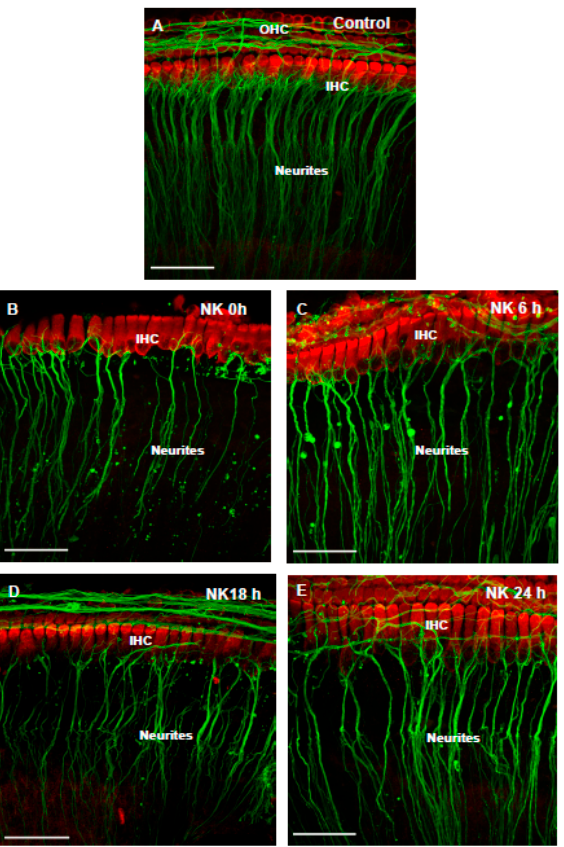
Figure 2. The effect of excitoxic injury in the neonatal rat cochlea induced by co-administration of N-methyl-D-aspartate ( NMDA) and kainic acid (NK treatment). Images B–E show the NK effect in the function of time in order to find the best post-NK time point for further experiments in the study. ( A ) P6 Wistar rat cochlea labelled with Myosin VIIa (red; sensory hair cells) and β -tubulin (green; neurites of the spiral ganglion neurons) in normal culture medium; ( B ) Immediately after incubation with NK; ( C ) 6 h; ( D ) 18 h; ( E ) 24 h after NK treatment. Images are representative of five experiments per time point. Scale bars, 50 µm.